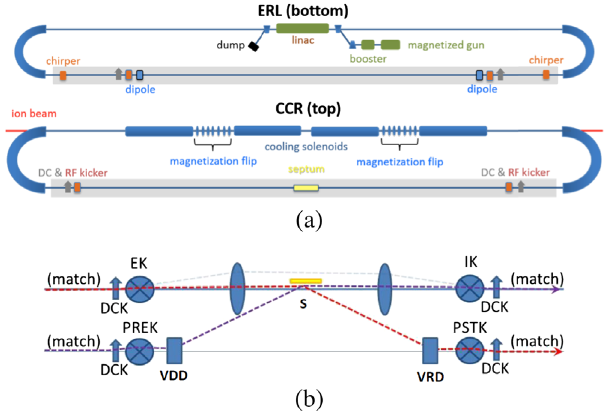
FIG. 1. The schematic view of the CCR. (a) Overview of the CCR. The grey colored box is the beam exchange region. (b) The expanded view of the exchange